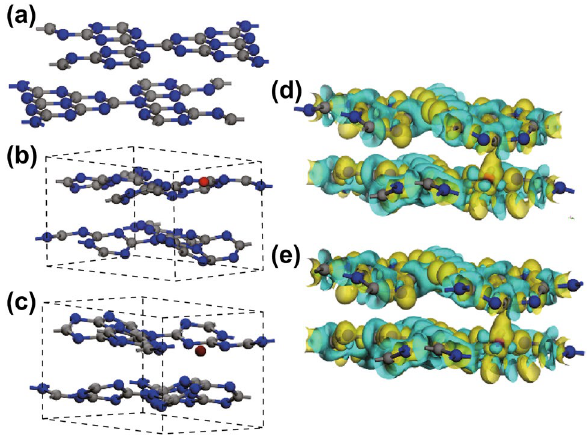
Fig. 8 Crystal structure of a P-CN, b Co-CN, and c Mo-CN, and charge density difference of d Co-CN and e